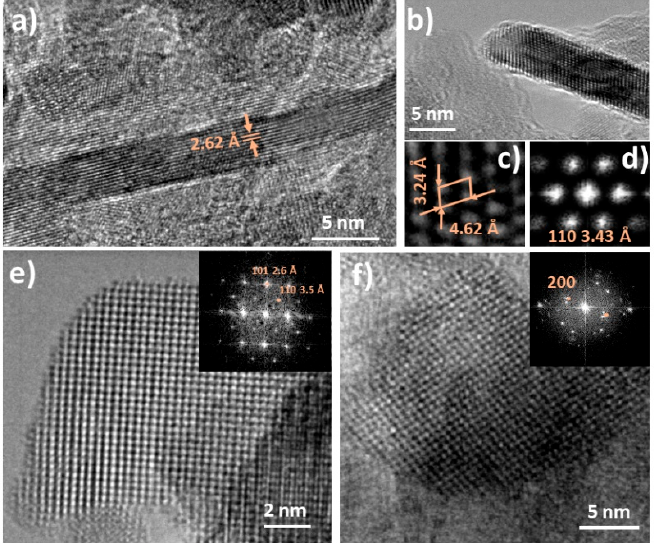
Figure 5. HRTEM images from the NiO30 sample. ( a ) Nanostick with interplanar distances corre- sponding to SnO 2 . ( b ) NiO30 nanostick with atomic resolution and their corresponding ( c ) I-FFT and ( d ) SAED pattern, confirming the SnO 2 rutile structure. ( e ) SnO 2 nanoparticle with the corresponding SAED pattern. ( f ) NiO nanoparticle with the corresponding SAED pattern.